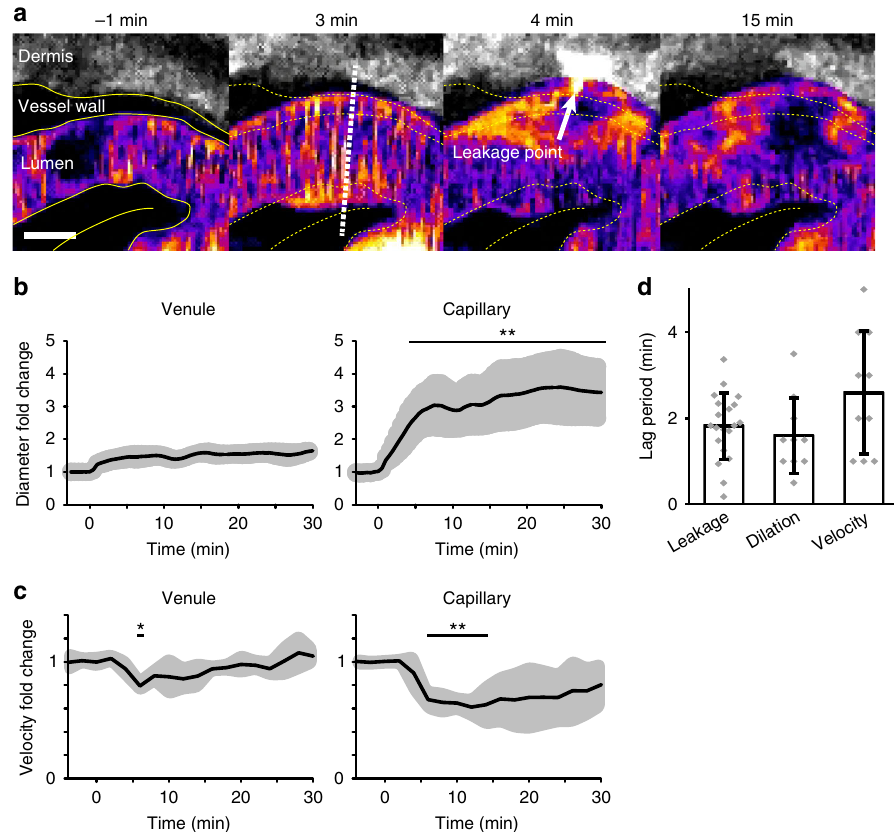
Fig. 5 Vasodilation and RBC velocity dynamics in response to VEGFA. a Illustration of vasodilation at a leakage point induced in response to VEGFA164 administration. Colors: 2000kDa FITC-Dextran in lumen; pseudocolor, 2000 kDa FITC-Dextran in dermis; white. White dotted line marks the position used for measurement of vessel diameter dynamics by FWHM at a leakage point (arrow). Bar, 5 μ m. b Kinetics of vasodilation at different time points after administration of VEGFA164, in venules (left) and capillaries (right). Gray area around solid black line indicates variability (S.D.) n = 3 mice (individual biological repeats) with 5 vessels of each kind analyzed. Student ’ s t -test; ** p < 0.01. c RBC velocity dynamics in response to VEGFA164 in venules (left) and capillaries (right). Gray area around solid black line indicates variability (S.D.) n = 3 mice and 5 vessels of each kind analyzed with more than 20